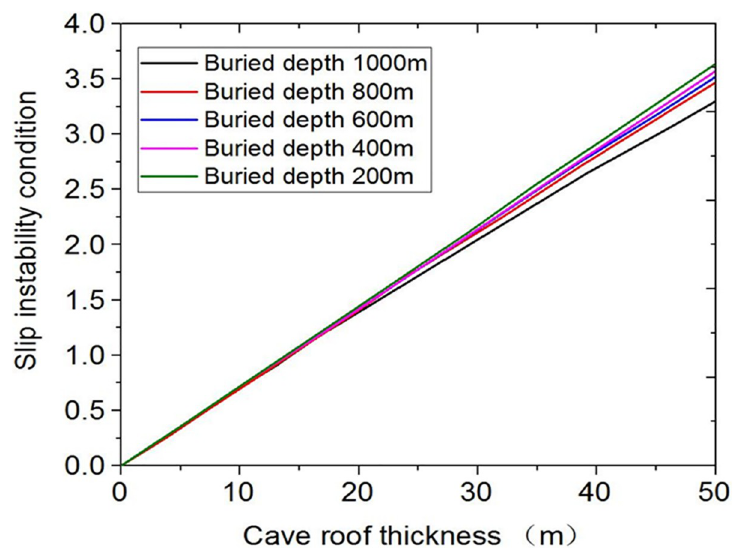
Fig 5. Influence curves of different buried